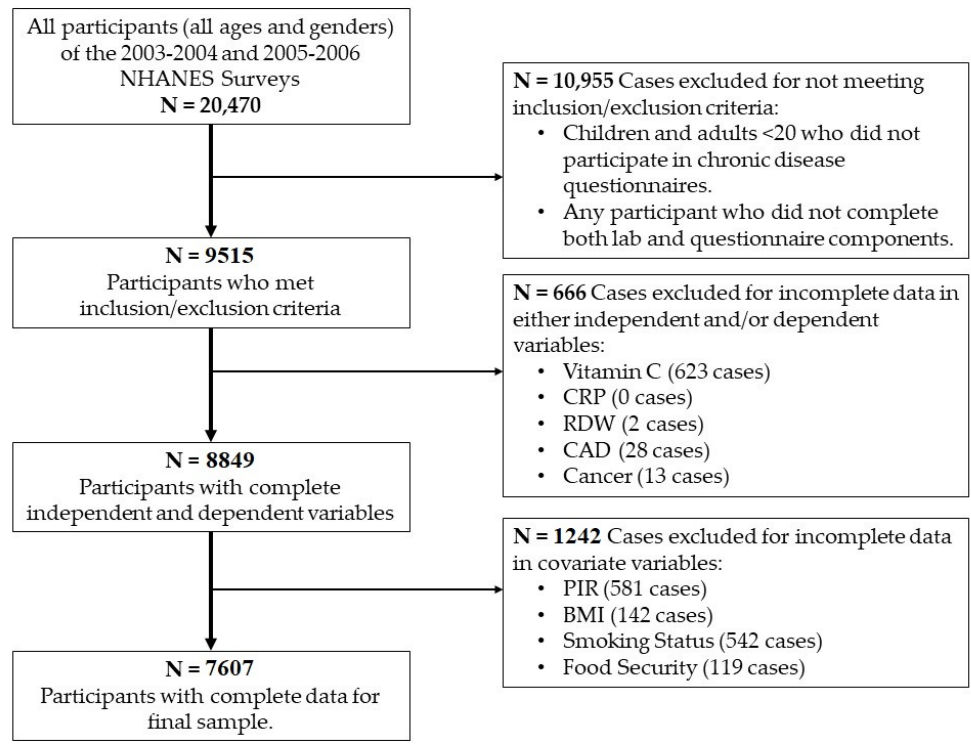
Figure 1. Sample Selection Flowsheet.